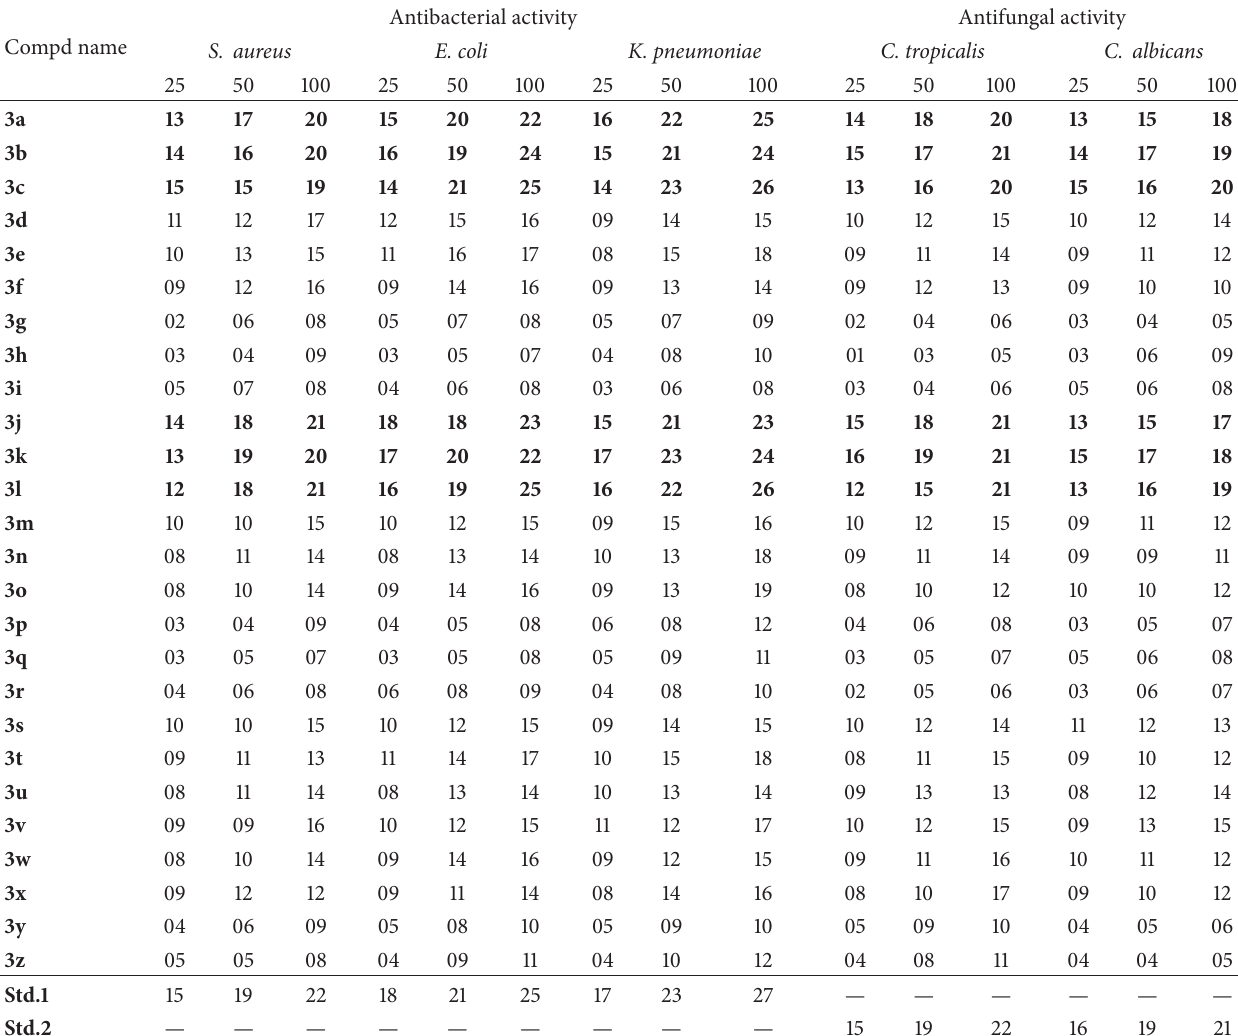
Std.1: gentamycin, Std.2: fluconazole. The bold font refers to the compounds which have shown more potent antimicrobial